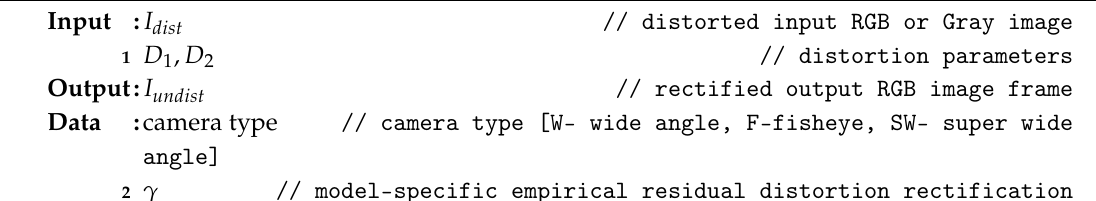
Figure 11. Severe distortion cases rectified using several approaches [28,29], proposed method with and without empirical γ -hyper parameter. Algorithm 2: Undistortion algorithm using distortion parameters,with and without γ hyper